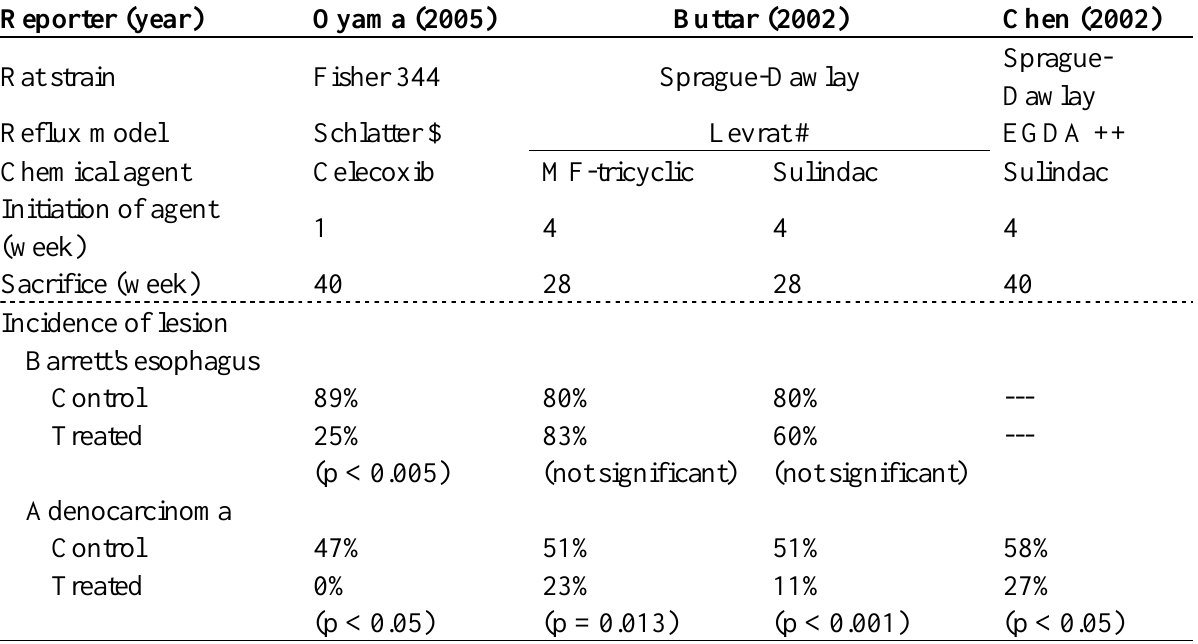
Table 1. Preventive effects on esophageal adenocarcinogenesis of COXIBs and NSAIDs using rodent reflux